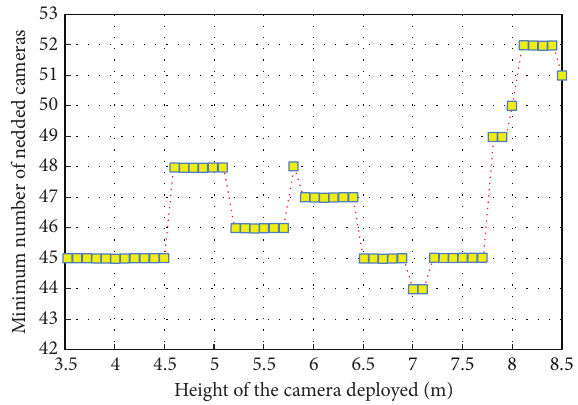
Figure 8: The minimum number of cameras versus deployed height.